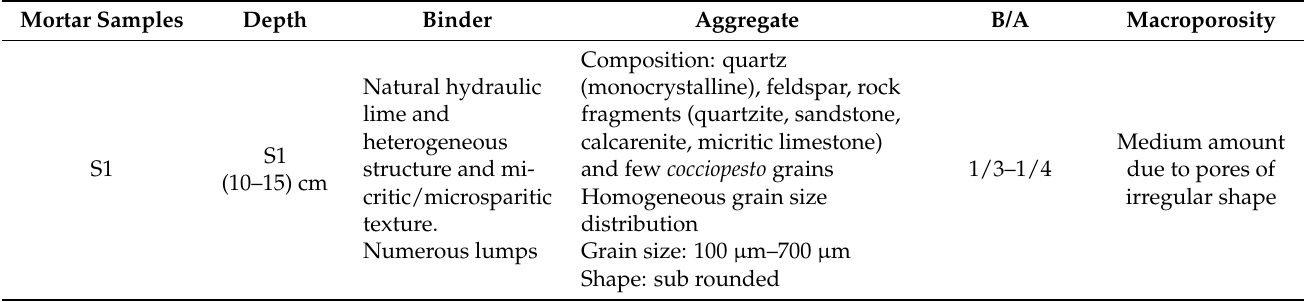
Table 4. Petrographic description of core samples (B/A = binder/aggregate